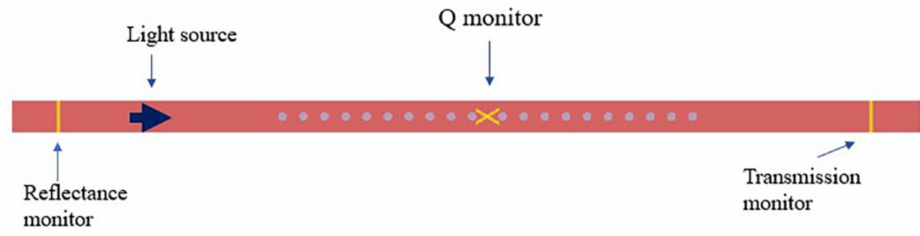
Figure 2. The simulation setup of the 1D PhC.